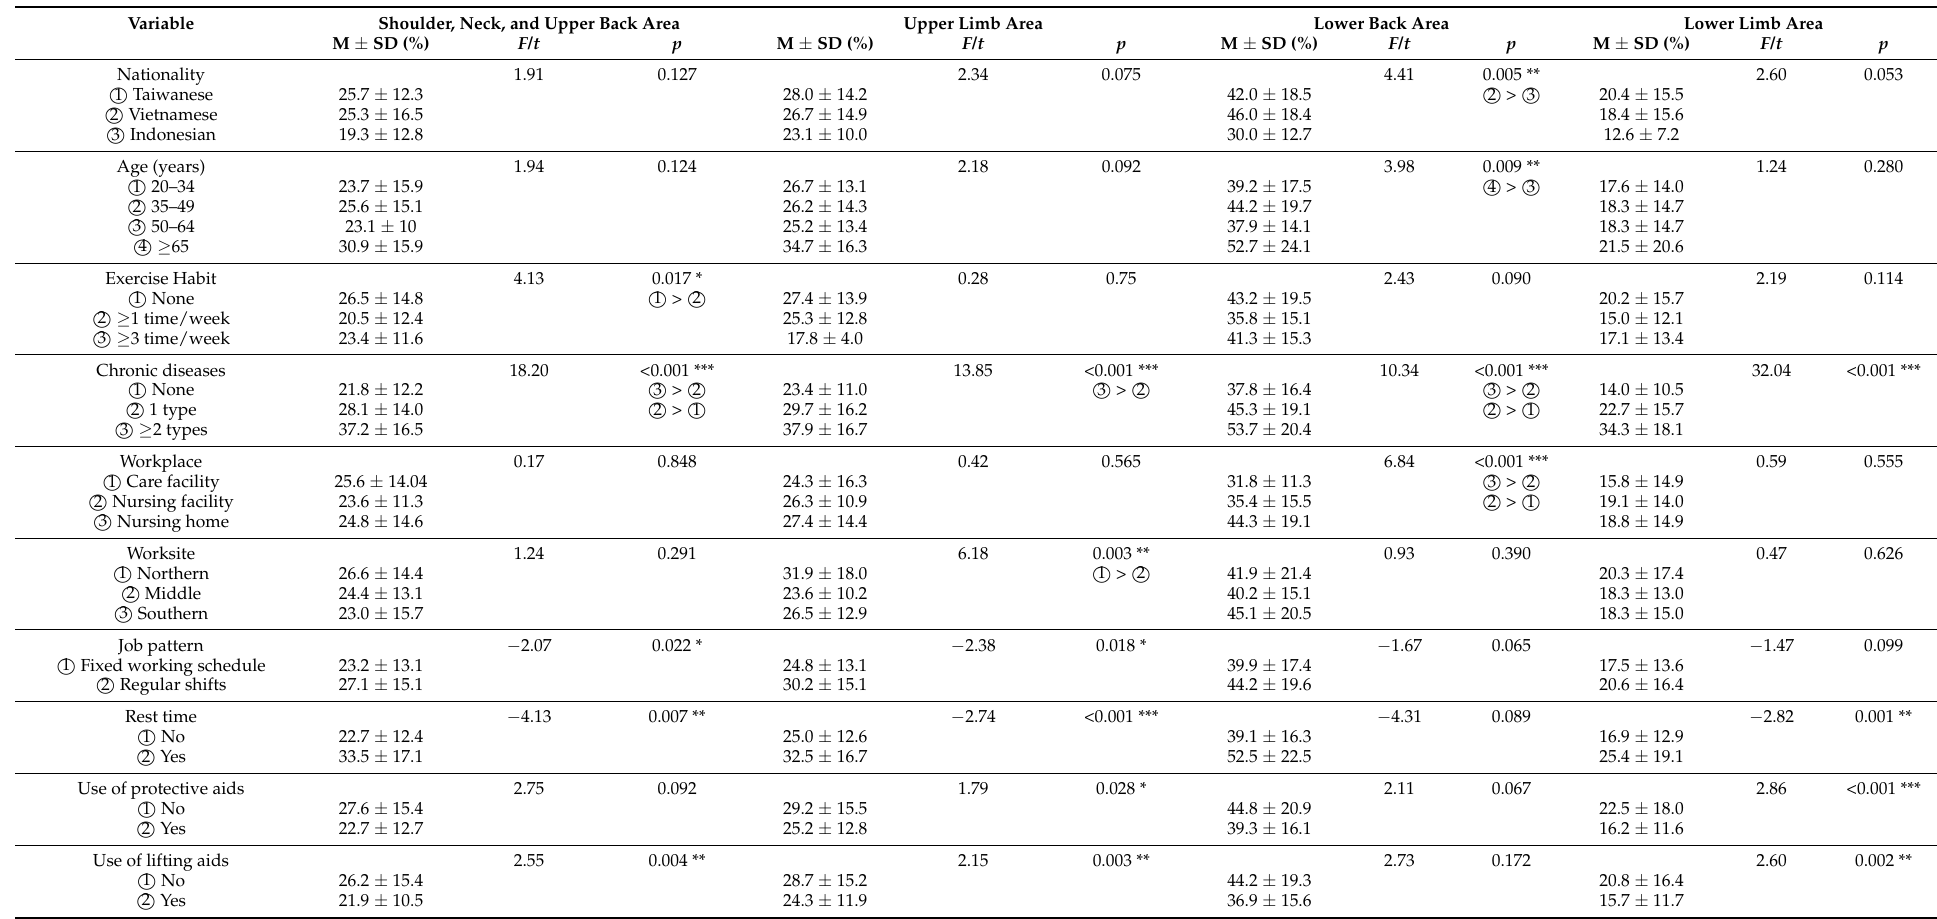
Table 3. Association of demographic characteristics and job background with MSDs in the four areas among nursing aides in LTCFs ( n =